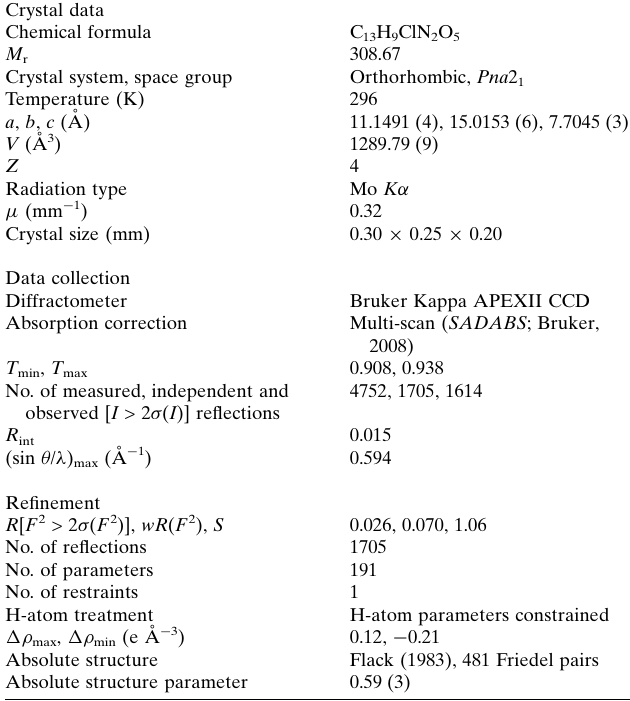
Table 2 Experimental details.